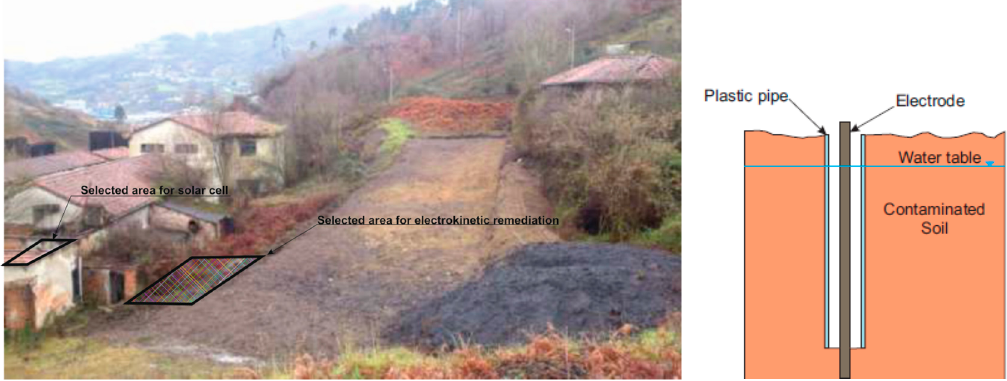
Figure 2. View of selected area for electrokinetic remediation field study and scheme of